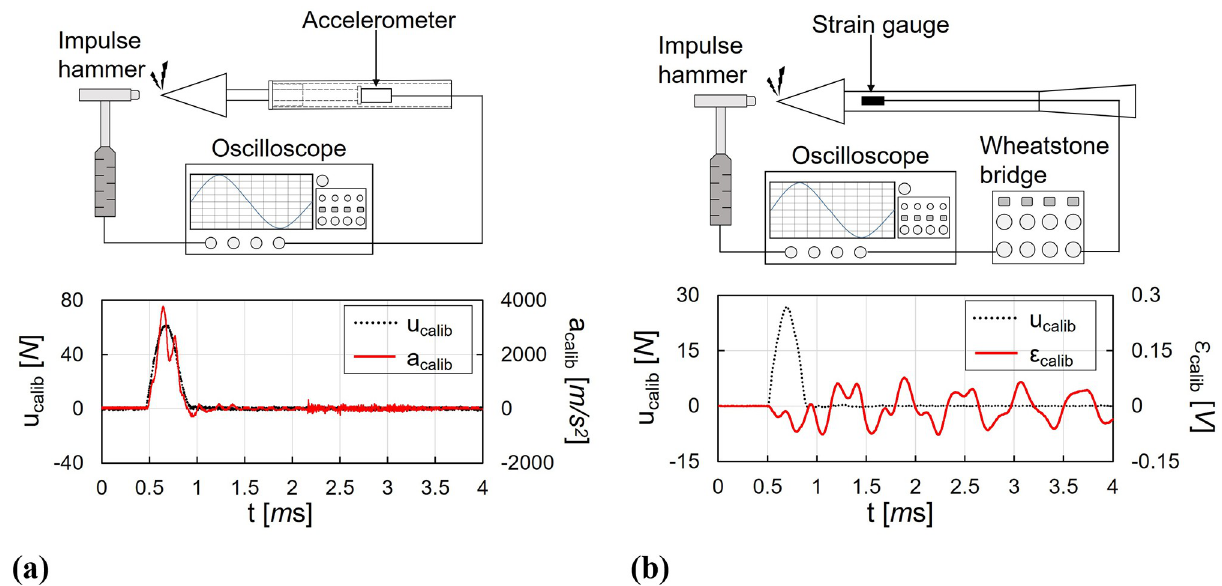
Fig 7. Dynamic calibration schematic and results. (a) MST, (b) SWT.